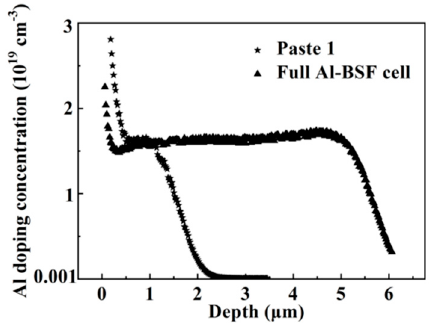
Figure 8. Comparative electrochemical capacitance-voltage (ECV) measurements of the doping profiles obtained in the Si substrates using the firing-through paste 1 and normal full-area Al-back-surface field (BSF) paste, respectively.